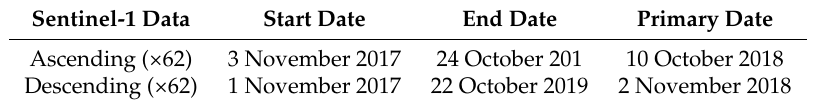
Table 2. Sentinel-1 radar data observation time frame and dates of the selected primary